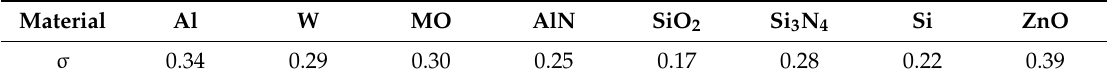
Table 2. The Poisson’s ratio of di ff erent materials. Data from